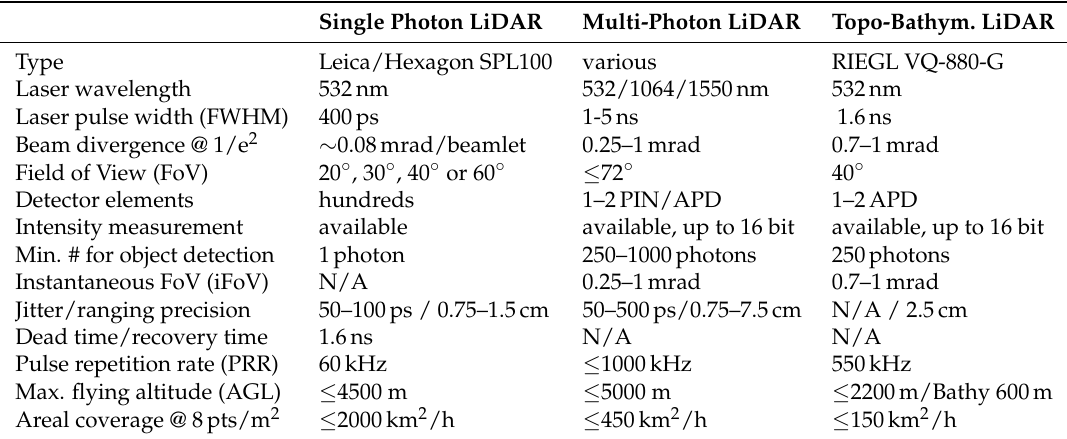
Table 1. Specifications for Single Photon LiDAR, Multi-Photon LiDAR, and Topo-Bathymetric LiDAR. For generalization purpose a standard combination of specifications from various companies is provided for conventional Multi-Photon LiDAR. Single Photon LiDAR Multi-Photon LiDAR Topo-Bathym.